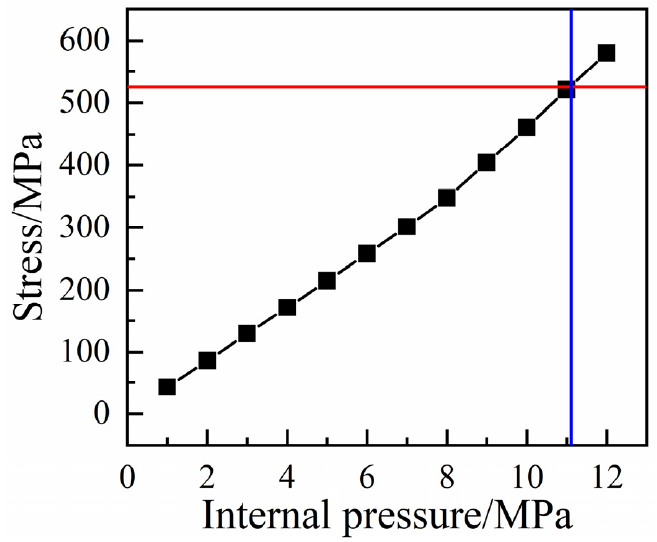
Figure 7. Stress-internal pressure curve for the innermost polyester fiber layer of the RTP.